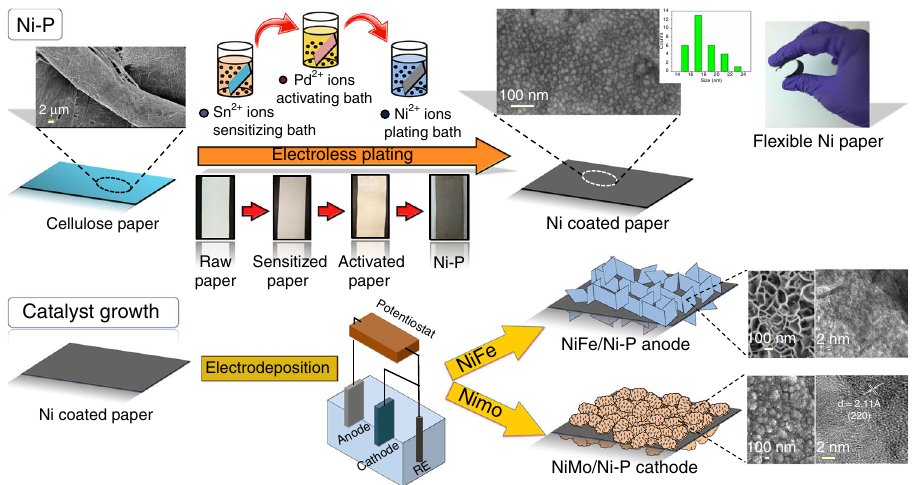
Fig. 1 Schematic illustration of the fabrication process. Digital images, fi eld-emission scanning electron microscopy and transmission electron microscopy images depicting various steps in the formation process of Ni-P, NiFe/Ni-P, and NiMo/Ni-P